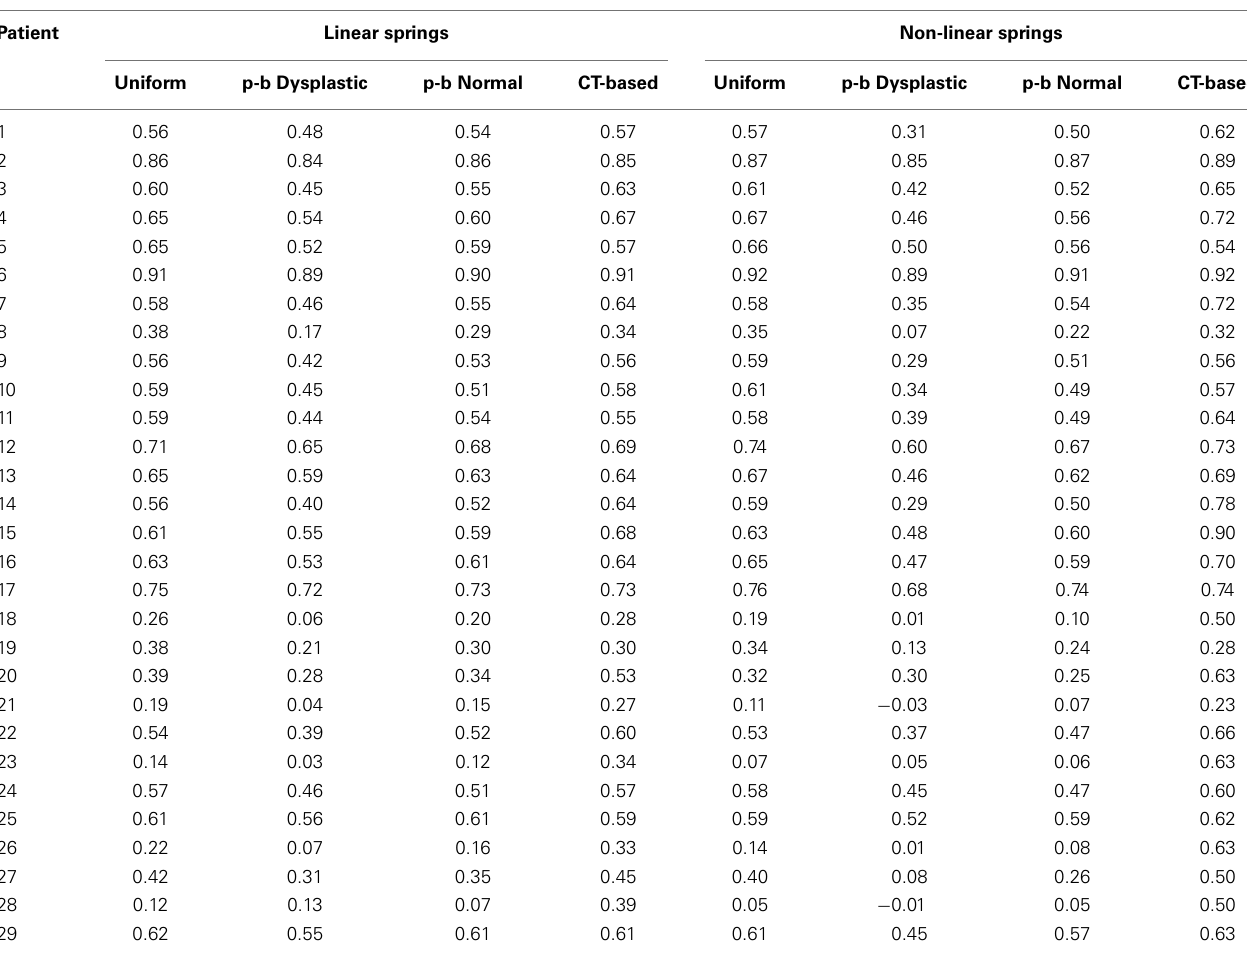
Table 2 | Relative decrease in peak contact pressure data (“p-b” denotes a population-based